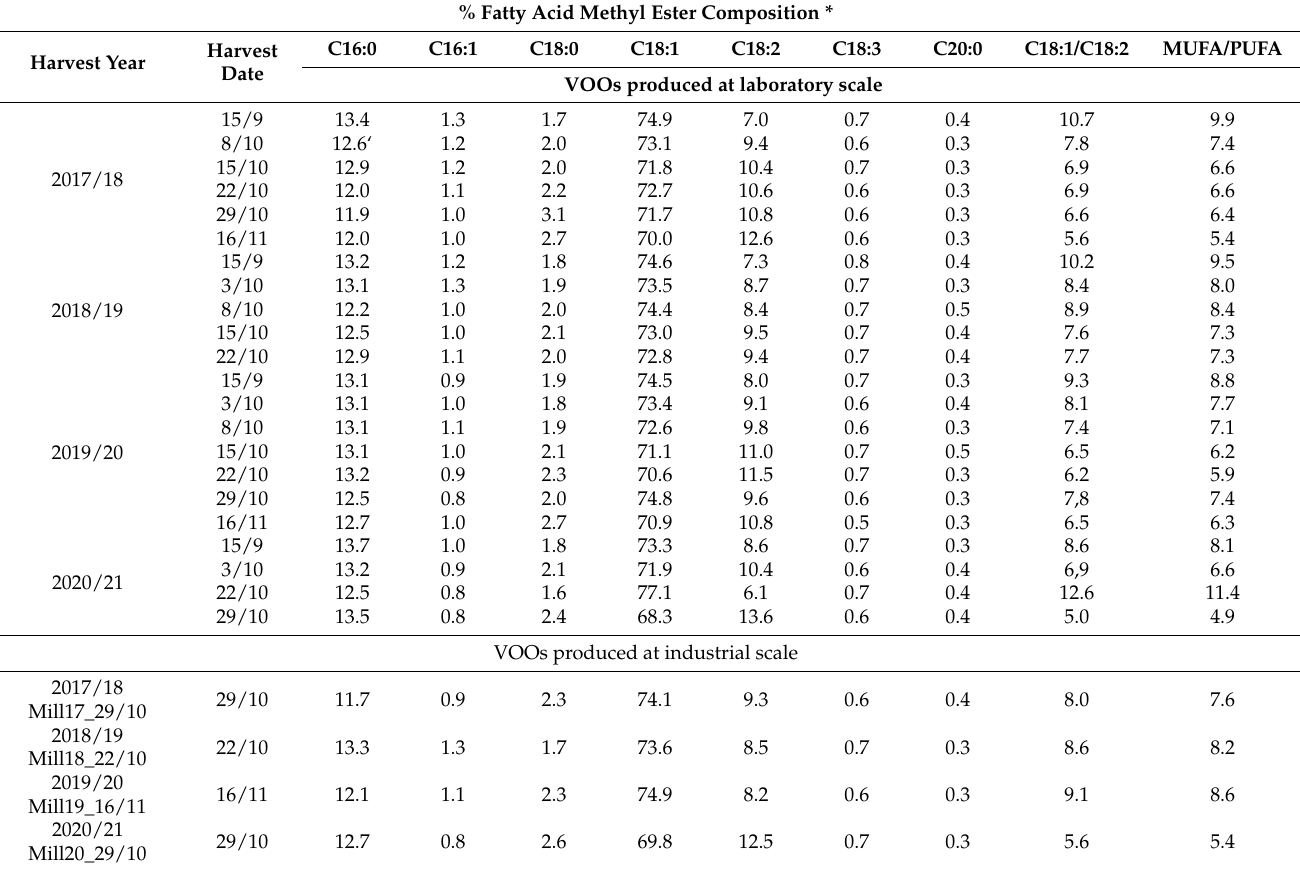
presented the maximum level of 2.7 % at a MI above 3.5. The maximum level of 4.4 % for stearic acid when the MI reached 5.5 was also reported for VOO cv. Souri [40] indicating its accumulation during maturation. Oleic acid exhibited a decreasing trend from a mean value of 74.3% at the beginning of the harvest period to 70.5% at MI between 3.7 and 4.0. This decrease was not continuous in 2019/20 and 2020/21, in which a sharp increase was observed at MI 3.8, and 3.3, respectively. Linoleic acid showed an opposite trend as the highest percentages were observed at higher MIs. As a result, a substantial decrease in oleic/linoleic acid and MUFA/PUFA ratio was observed during maturation, which can be attributed to the transformation of oleic acid into linoleic acid by the enzyme oleate desaturase, which is active during triacylglycerol biosynthesis [32], as well as the high field temperatures [41]. Lower values of MUFA/PUFA ratio have been reported for VOOs produced in warm seasons and areas [41]. During summer, daily temperatures did no exceed 33 ◦ C for all harvest years; the lowest mean temperature (27 ◦ C) was recorded in 2020–2021. The MUFA/PUFA ratio in the VOOs cv. Chondrolia Chalkidikis and Chalkidiki at MI 3.7–4.0 presented half value (5.5, n = 3) to the corresponding one (10.4) for a VOO cv. Koroneiki from olive fruit of the same MI [42]. The latter did not necessarily indicate lower stability of VOOs cv. Chondrolia Chalkidikis and Chalkidiki as its oxidative status is also strongly affected by the concentration in natural antioxidants. The fatty acid composition of the samples from the olive mill showed intermediate values between those observed for samples extracted at laboratory scale (Table 4). The VOOs stood out for their high content of oleic acid, which permits the use of the respective health claim. Table 5. Effect of the harvesting date on the % fatty acid composition of the produced VOOs for four consecutive harvest years (2017/18, 2018/19, 2019/20, 2020/21). % Fatty Acid Methyl Ester Composition * Harvest Harvest Year Date